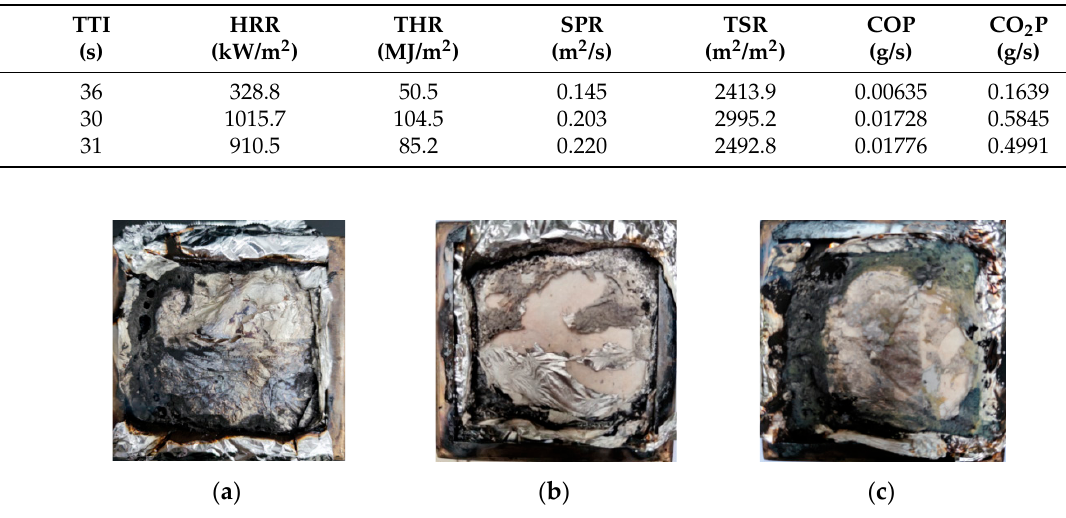
Figure 6. Images of residue after the cone calorimeter test using different materials: ( a ) Base asphalt, ( b ) epoxy resin, and( c ) epoxy asphalt.